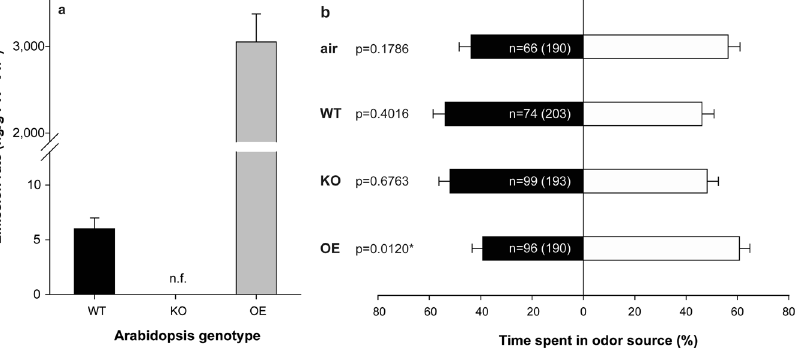
Figure 3. ( a ) Quantitative measurement of β -caryophyllene emitted by flowering plants of different Arabidopsis thaliana (Col-0 background) accessions: wild type (WT), β -caryophyllene knock-out mutant of At5g23960 (KO) and transgenic line β -caryophyllene synthase-overexpressing At5g23960 (OE). n.f., not found. ( b ) Responses of D . citri , tested in a 4-arm-olfactometer, to volatiles of two sets of odour sources. WT, KO and OE (see above) Arabidopsis thaliana (black bars) lines were tested against pots with substrate (withe bars). Bars represent the overall percentages of time spent in each of the two odour sources. Error bars represent SE (n = 10 independent test). The number of responding psyllids is indicated in the black bars and the total number of insects tested is given between parentheses for each comparison. Time spent in odor sources were analysed by paired t -test. Asterisks indicate significant differences between odour sources ( * P <